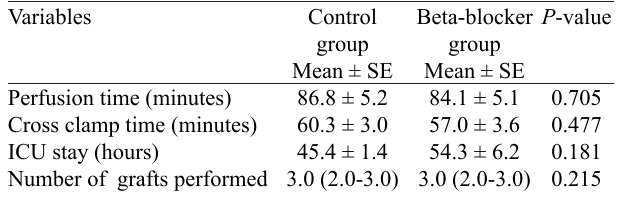
Table 3. Surgical characteristics in the control and beta-blocker groups.